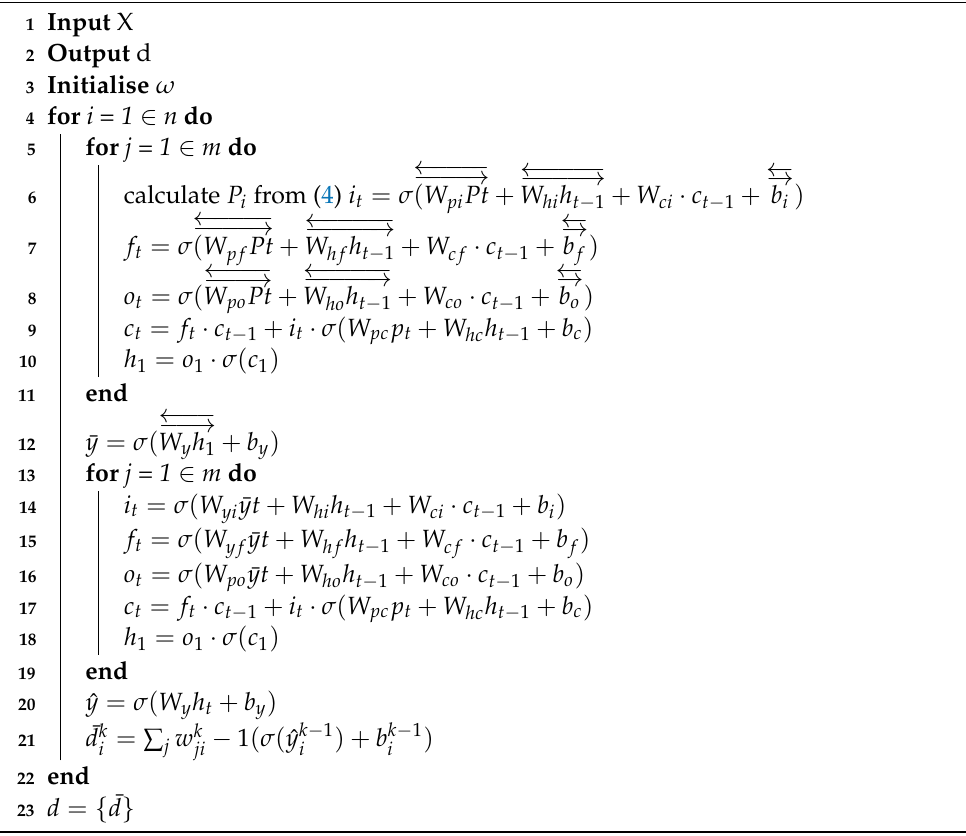
Algorithm 1: CBLSTM-AE